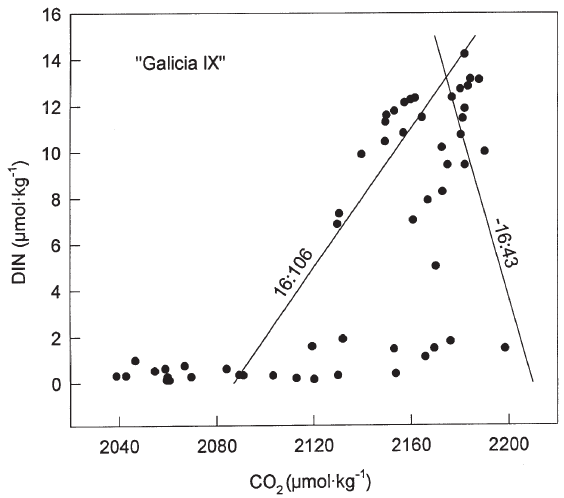
FIG. 2.- Relationship between total inorganic nitrogen (DIN) and in six stations of “Galicia IX” cruise. Line 16:106 corres- CO 2 ponds to the synthesis of organic matter by diatoms following Redfield. Line -16:43 indicates synthesis at nutricline by dinofla- gellates.